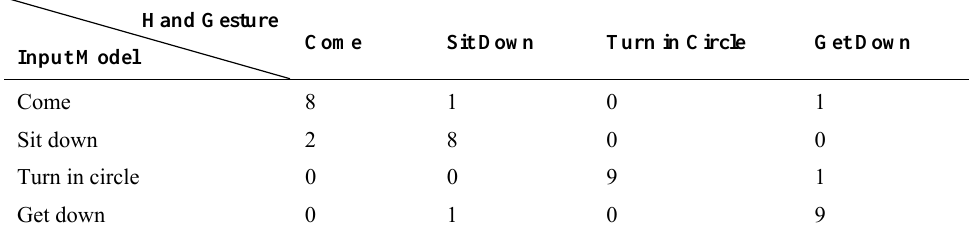
Table 7. Confusion matrix for recognition results of dynamic hand gestures with a FD HMM.